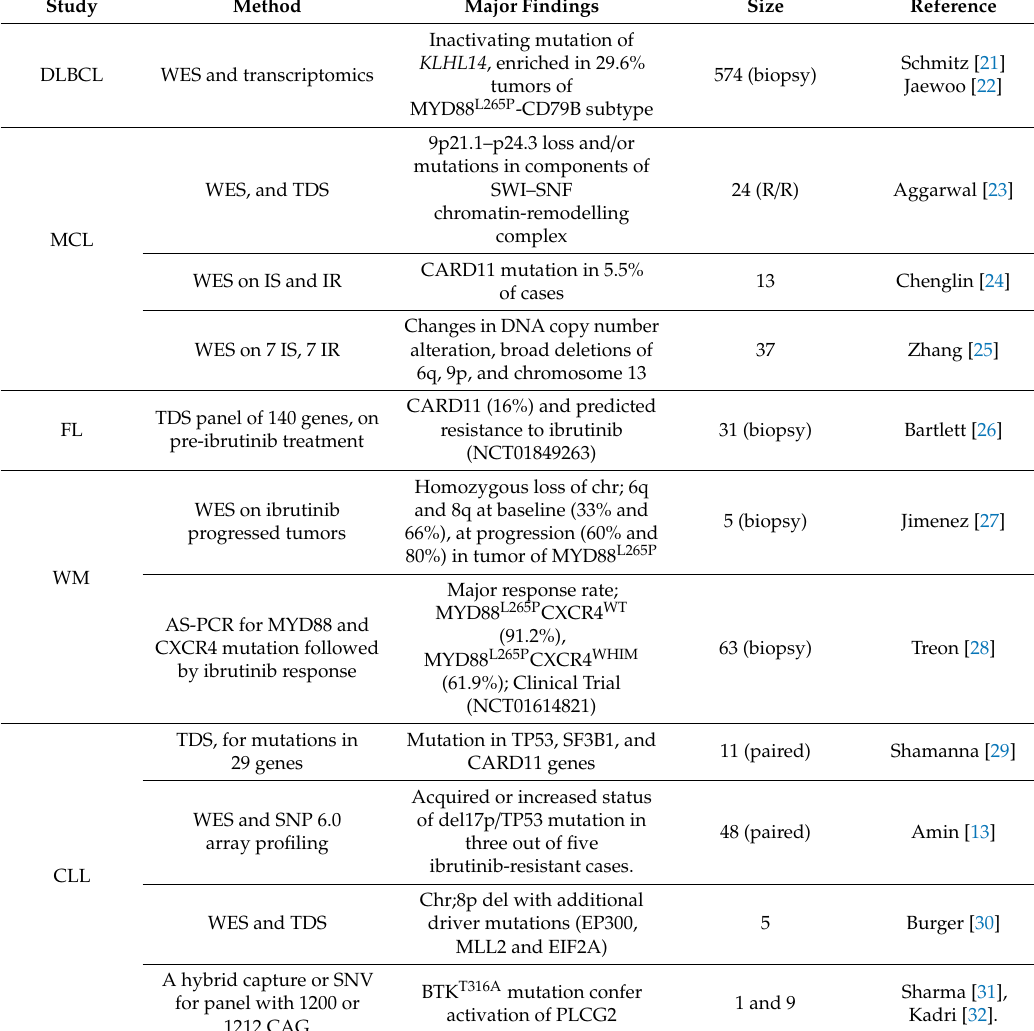
Selected next-generation-sequencing-based studies that identified alternative genetic aberrations other than BTK or PLCG2 mutations, acquired or clonally selected during disease progression to ibrutinib